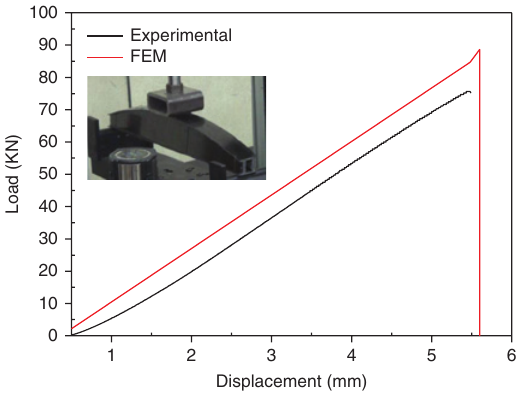
Figure 10: Load-deformation curve of the box girder in bending